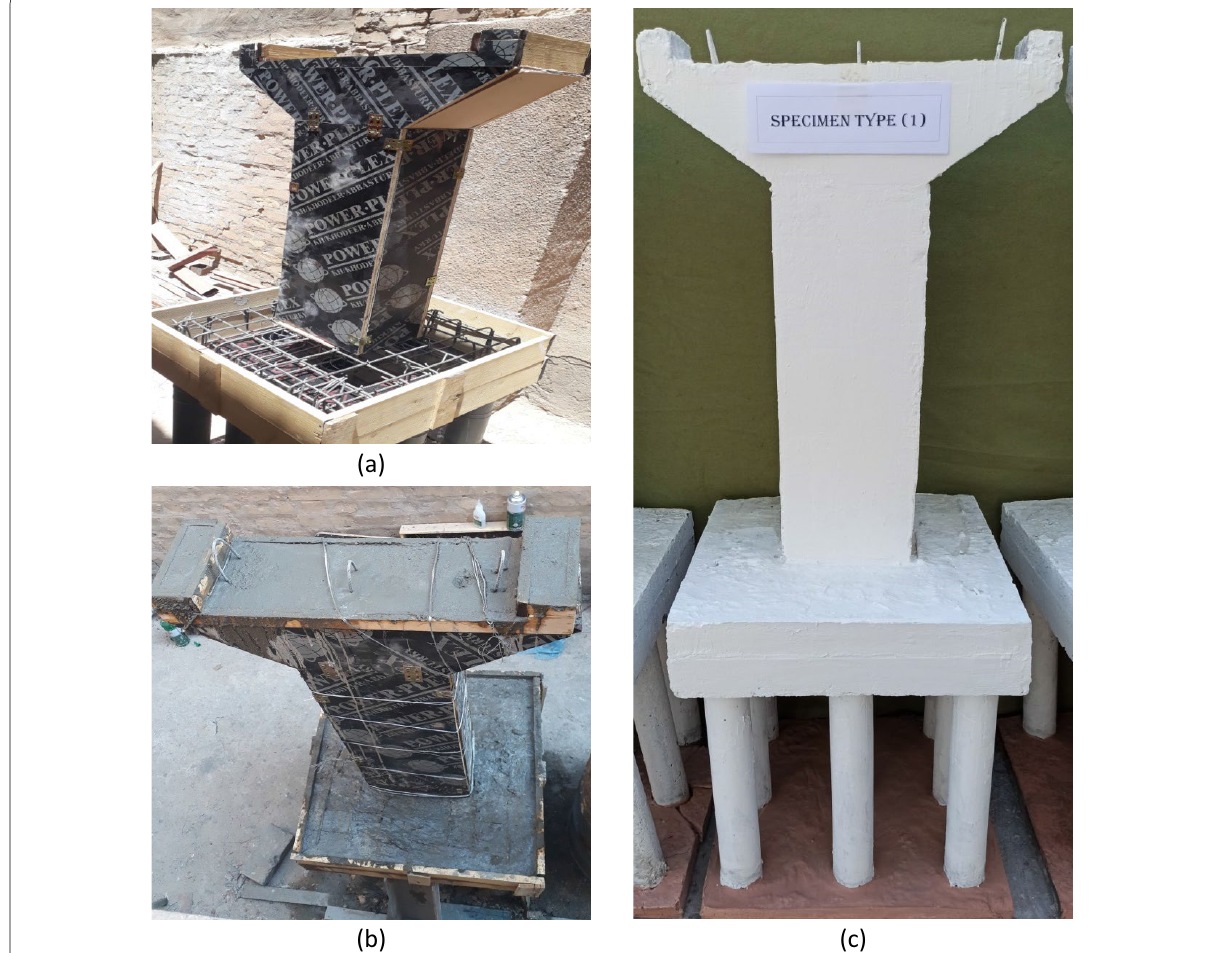
Fig. 4 Steps of model fabrication. a Model timber form. b Model concrete casting. c Final appearance of the